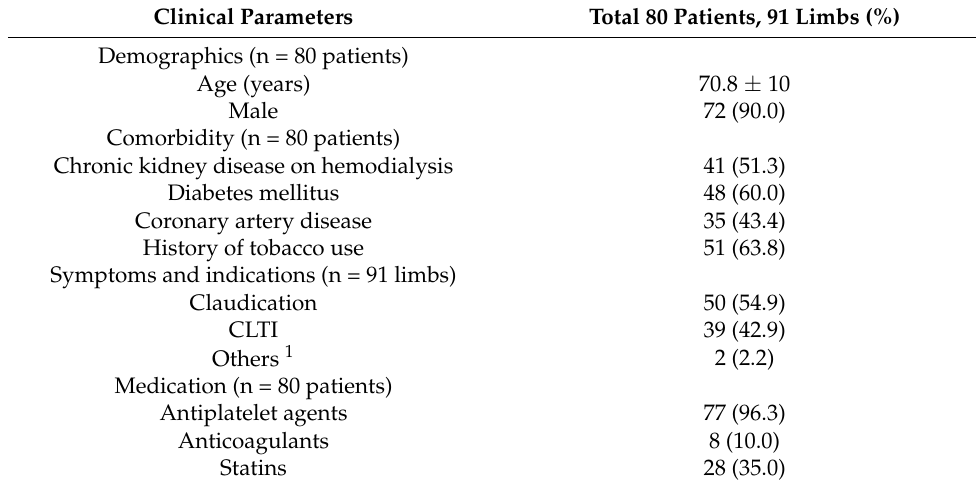
Table 1. Clinical background of the patients.